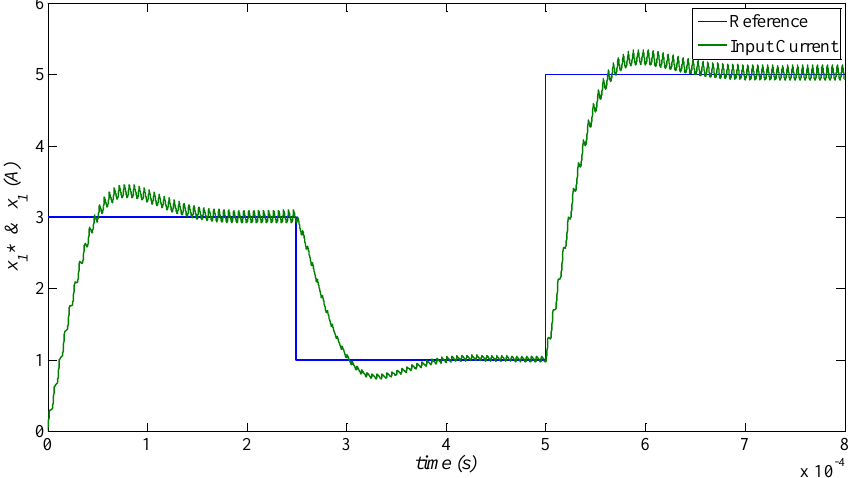
Figure 8. Step response of the improved linear controller.